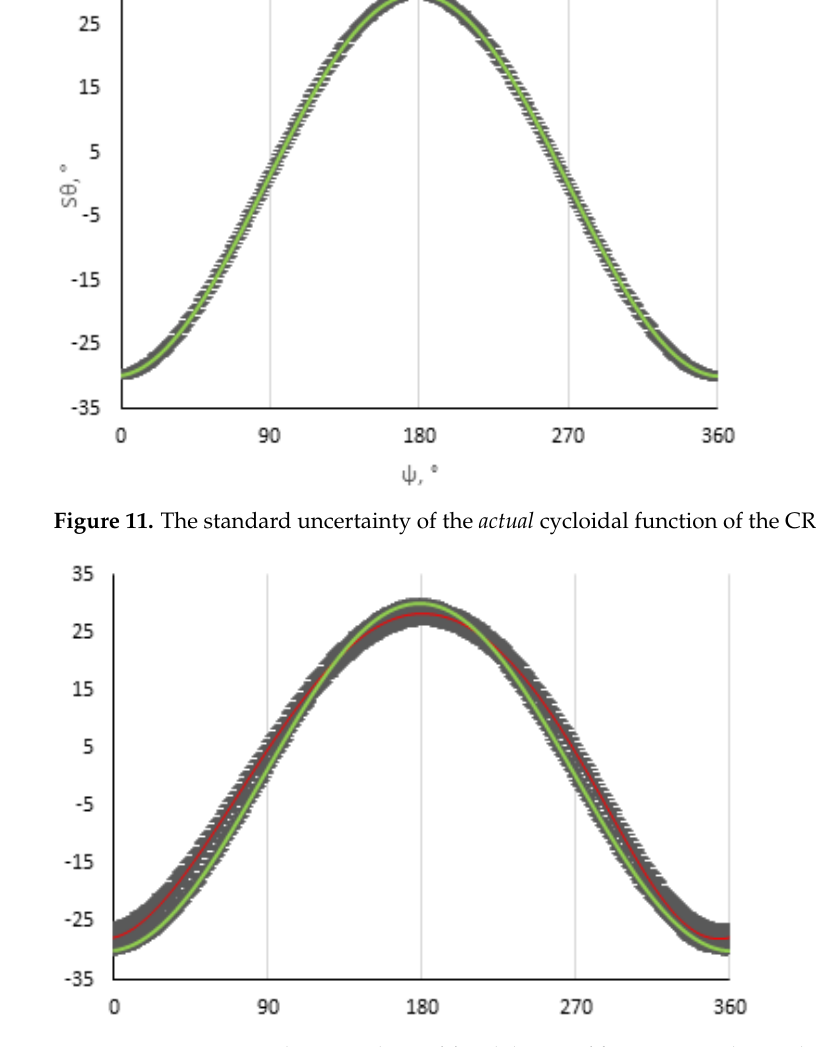
Figure 12. Comparison between the model and the actual function together with standard uncertain ‐ ties.